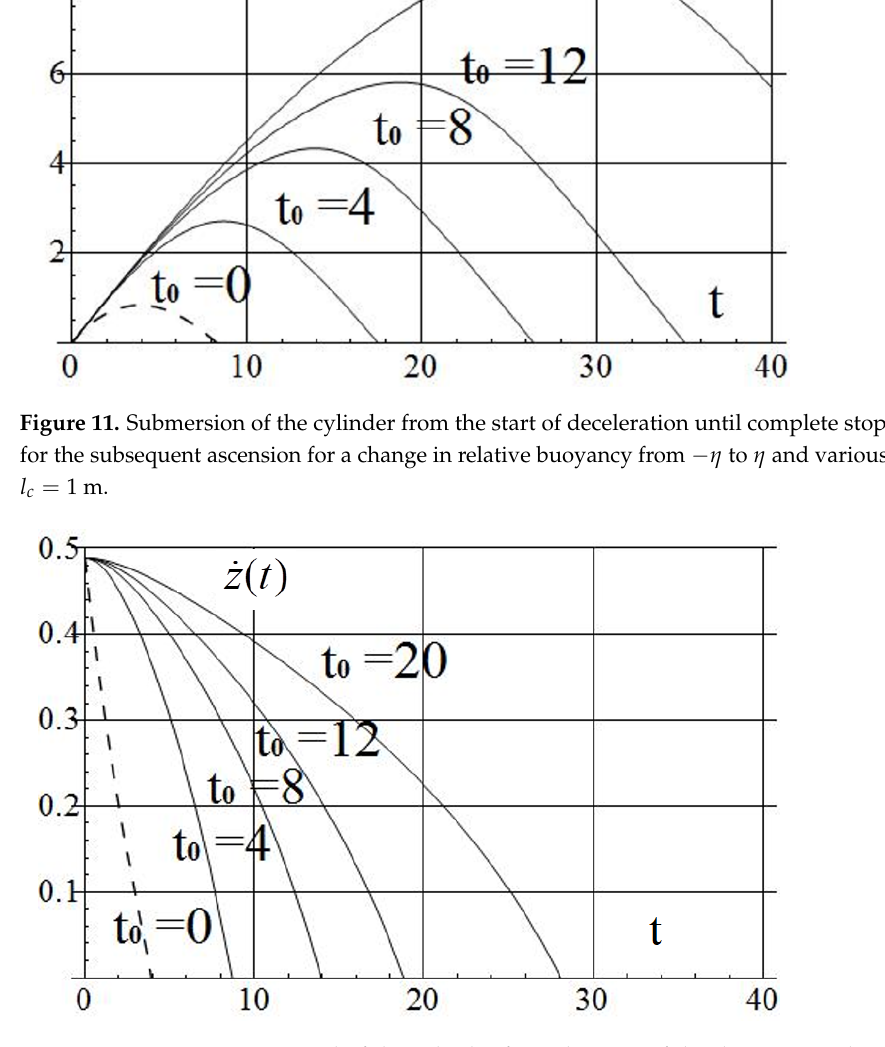
Figure 12. Instantaneous speed of the cylinder from the start of deceleration until complete stop accounting for the subsequent ascension for a change in relative buoyancy from − η to η and various t 0 , η = 0.01, l c = 1